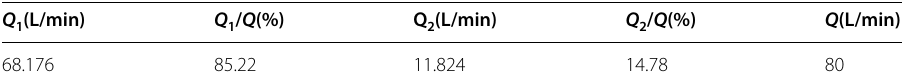
Table 1 Flow rate ratio of the model